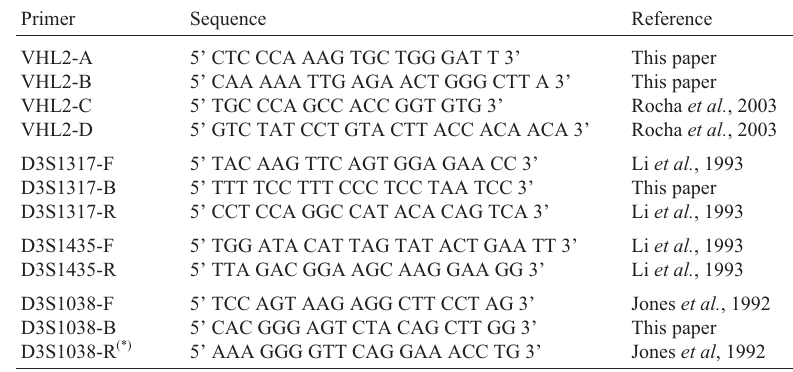
Table 1 - Sequence of primers used for preimplantation genetic diagnosis of Von Hippel-Lindau disease.